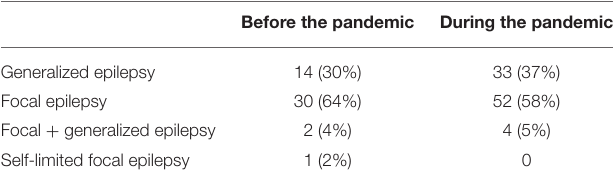
TABLE 1 | Summary of epilepsy types in the H–GP group before and during the first peak of the pandemic. Before the pandemic